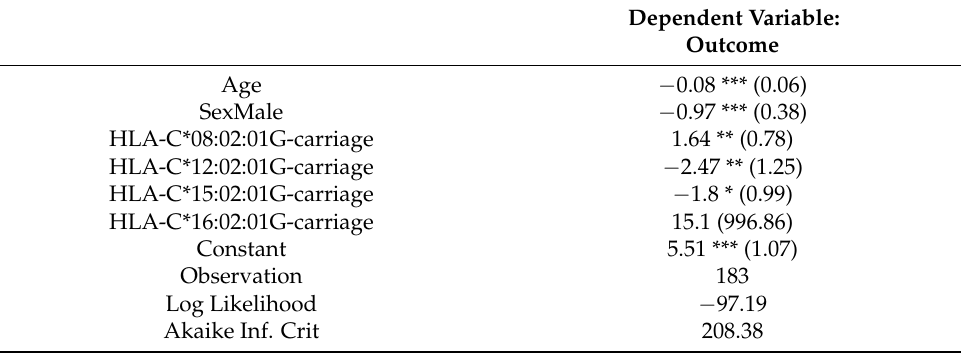
Table 10. Coefficients for “Best” model by AIC for locus C.